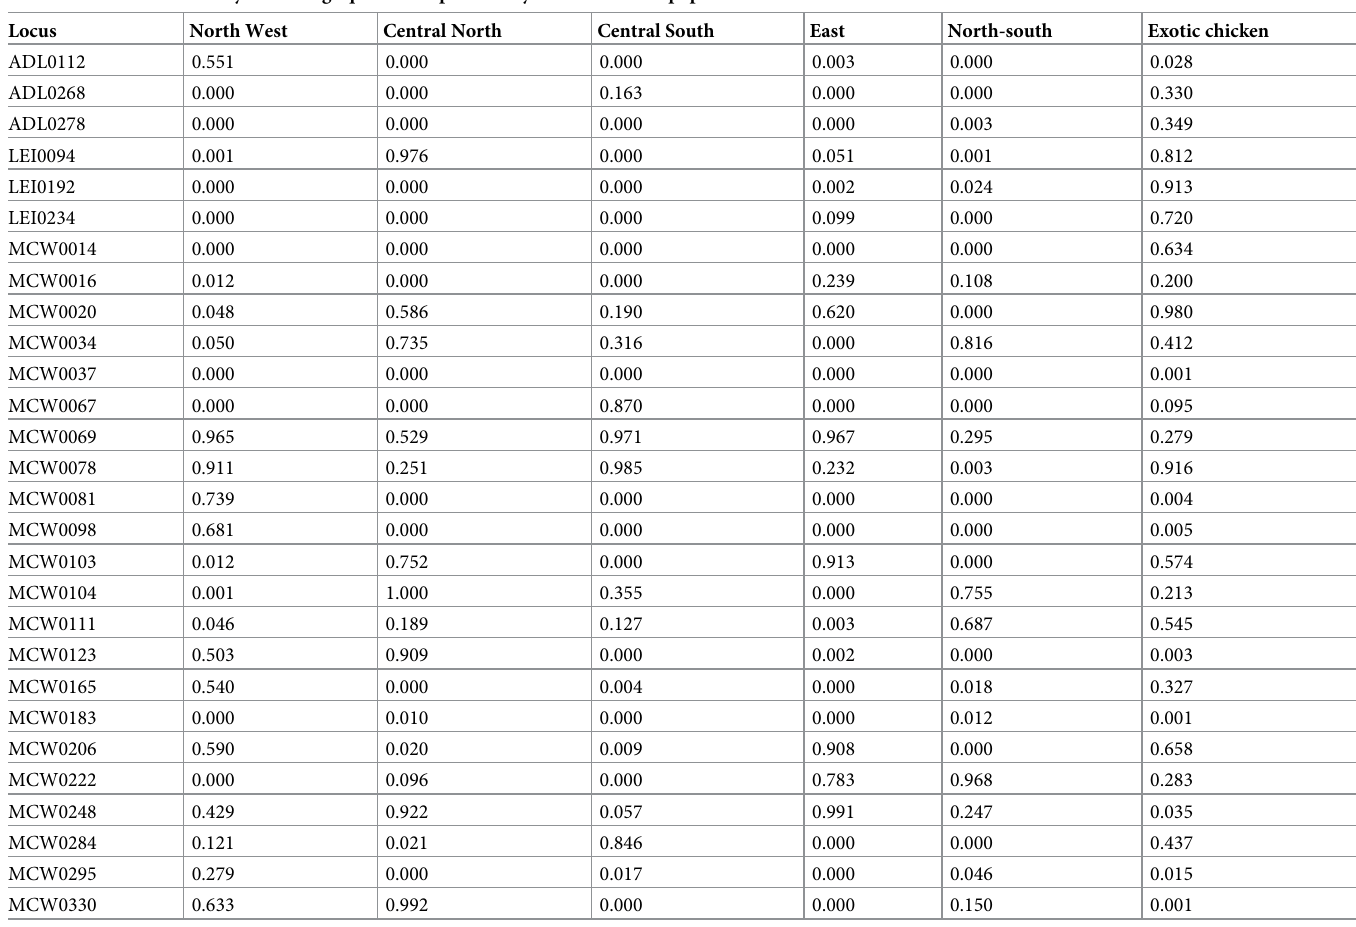
The results of the Factorial Correspondence Analysis (FCA) are depicted in Fig 5. It showed tree clusters whereby the Eastern region was still standing alone. NW and CN populations clustered together. Finally, the majority of individuals from the CS, SW and exotic chicken were in the same group. Table 4. Tests for the Hardy-Weinberg equilibrium probability of loci in the IC population in Rwanda. Locus North West Central North Exotic